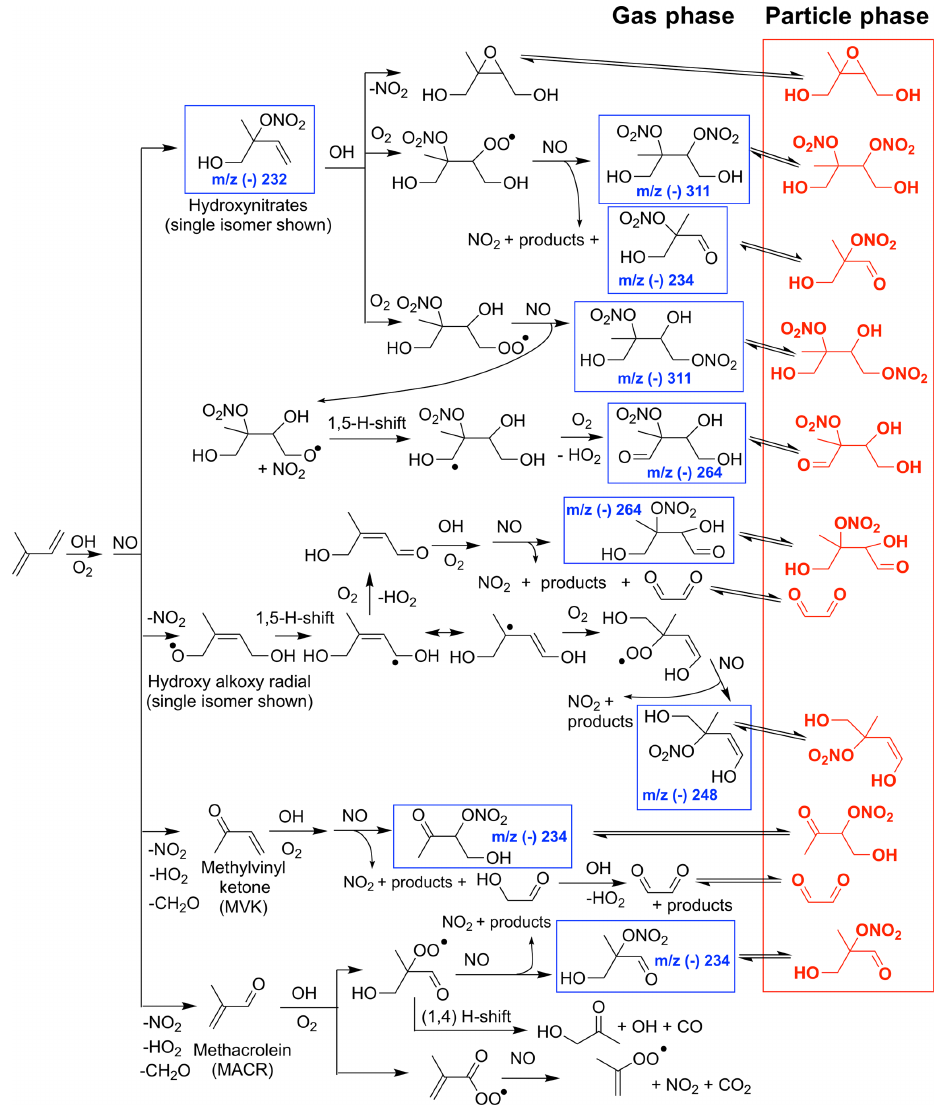
Figure 1. Simplified chemical mechanism of isoprene OH-initiated oxidation under high-NO conditions, largely based on schemes in Wennberg et al. (2018), emphasizing SOA generated from the LV pathway, which includes low-volatility organic nitrates and dinitrates in red. Compounds detected in the gas phase by the chemical ionization mass spectrometer (CIMS) are highlighted with a blue